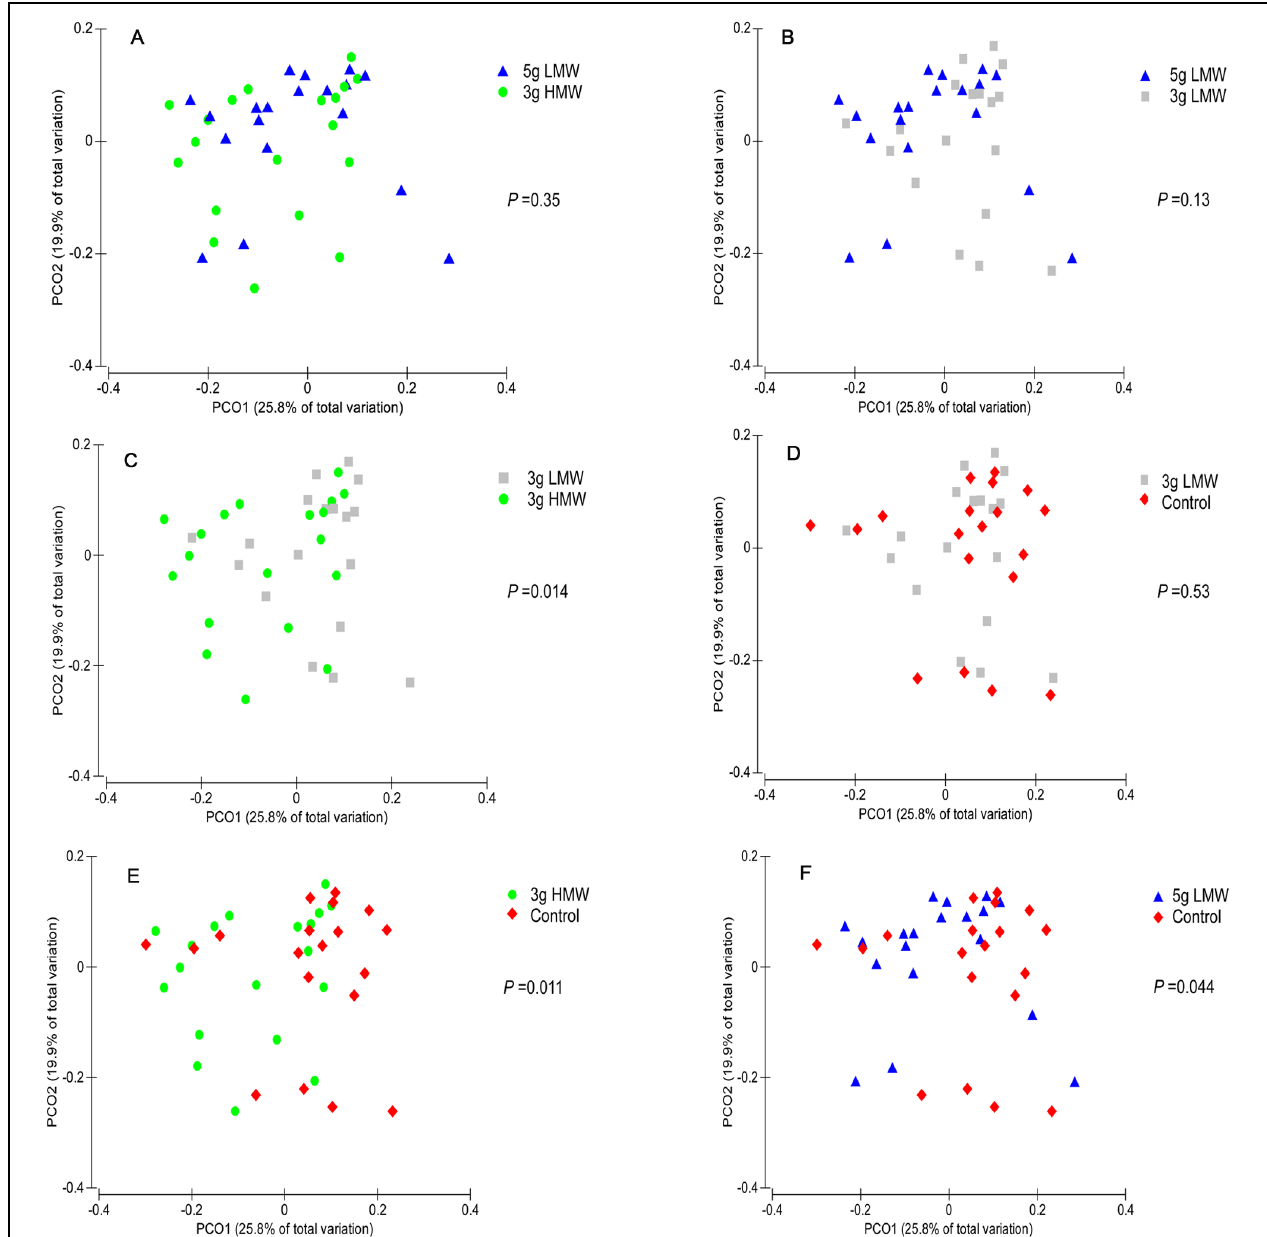
FIGURE 1 | Principal coordinates analysis (PCoA) of weighted UniFrac distances. Between community diversity among stool samples was tested for the impact of β -glucan amount and MW on the clustering patterns of microbiota in (A) 5 g LMW vs. 3 g HMW ( P = 0.35), (B) 3 g LMW vs. 3 g HMW ( P = 0.13), (C) 3 g